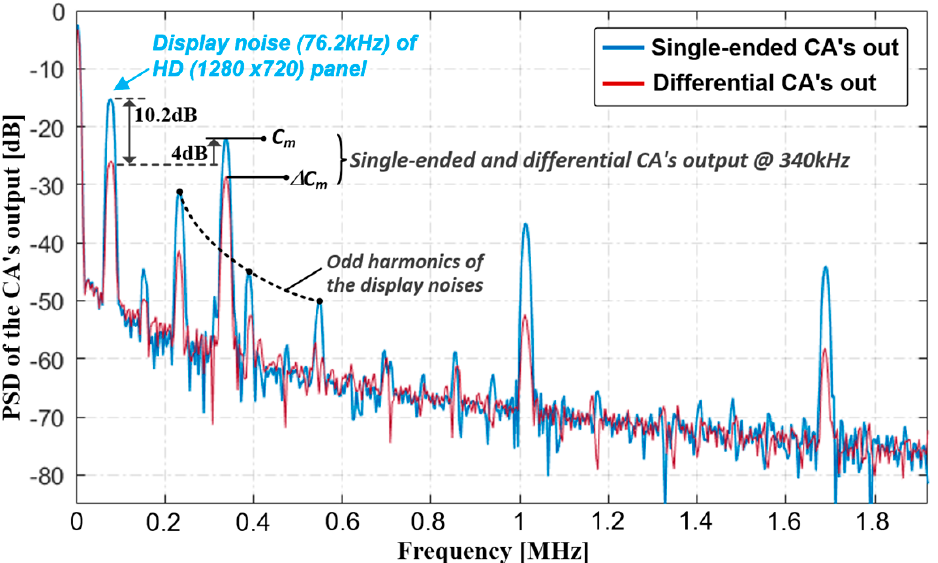
Figure 18. As the pixel-charging signal was a square wave during Scan[1:H], the display noise contained several odd-harmonic components of f sync . According to the measurement, the noise amplitude was reduced by 10.2 dB in comparison to that of single-ended sensing, and the noise-immunity performance converged to that of the C ref s.